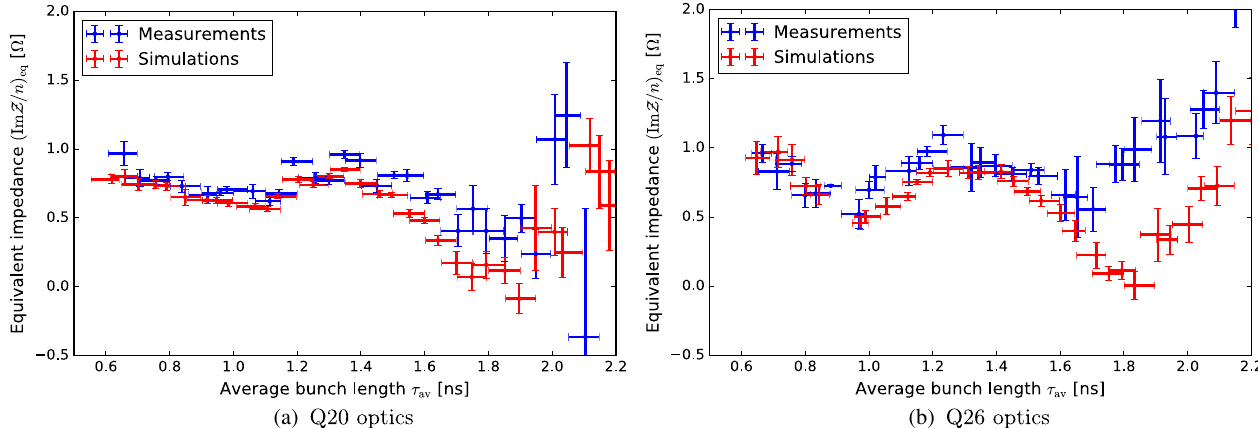
FIG. 15. Equivalent impedance ð Im Z =n Þ as a function of bunch length obtained from measurements (blue) and simulations (red) eq using the full SPS impedance model in the Q20 (left) and Q26 (right) optics.